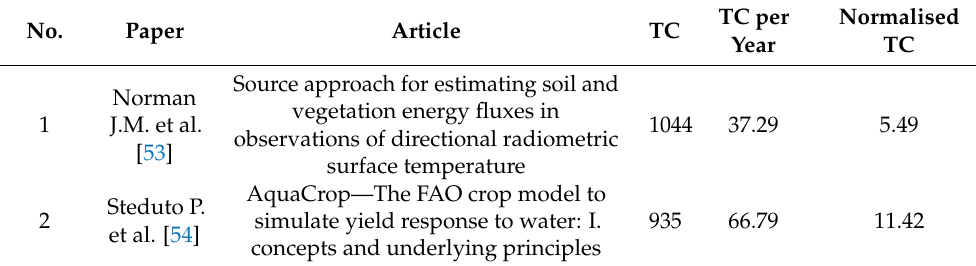
Table 5. Most Global Cited